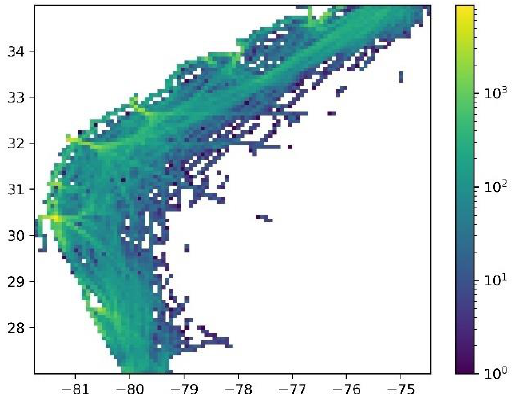
Figure 10. Grid map of maritime traffic density in the maritime area near the east coast of North America.